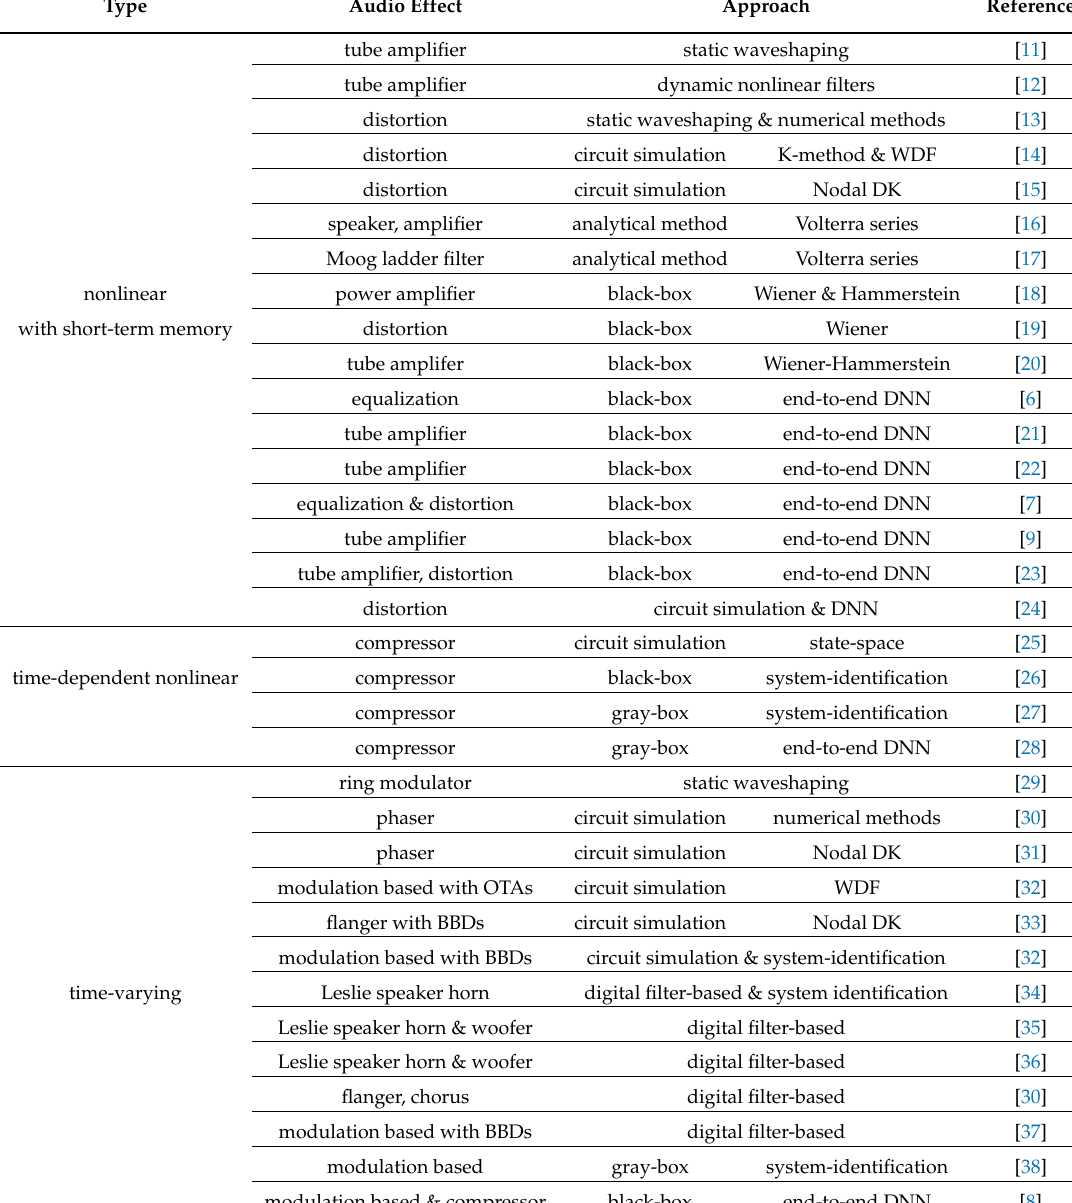
Table 1. Summary of approaches for virtual analog modeling of audio